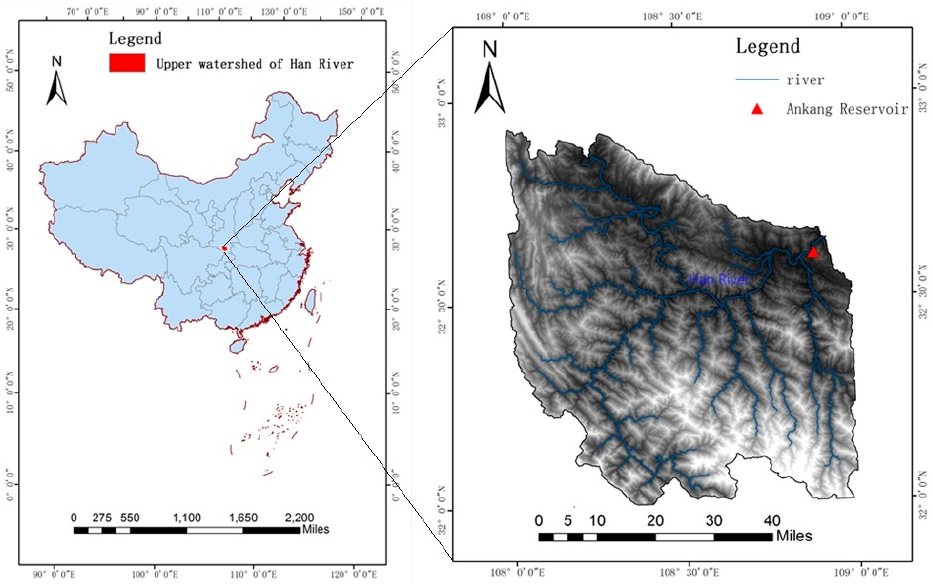
Figure 3. The location of Ankang Reservoir.